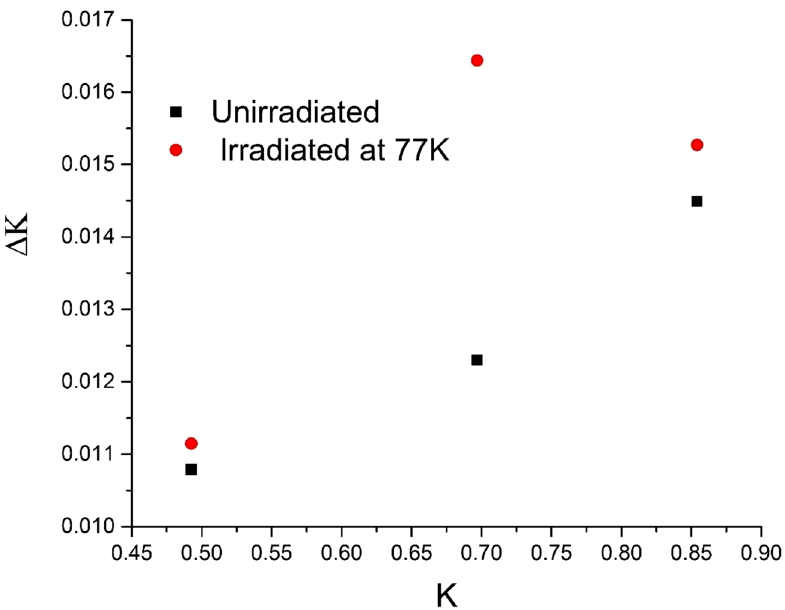
Figure 4. W–H plot for the unirradiated sample and for an irradiated sample at 77 K (as a representative